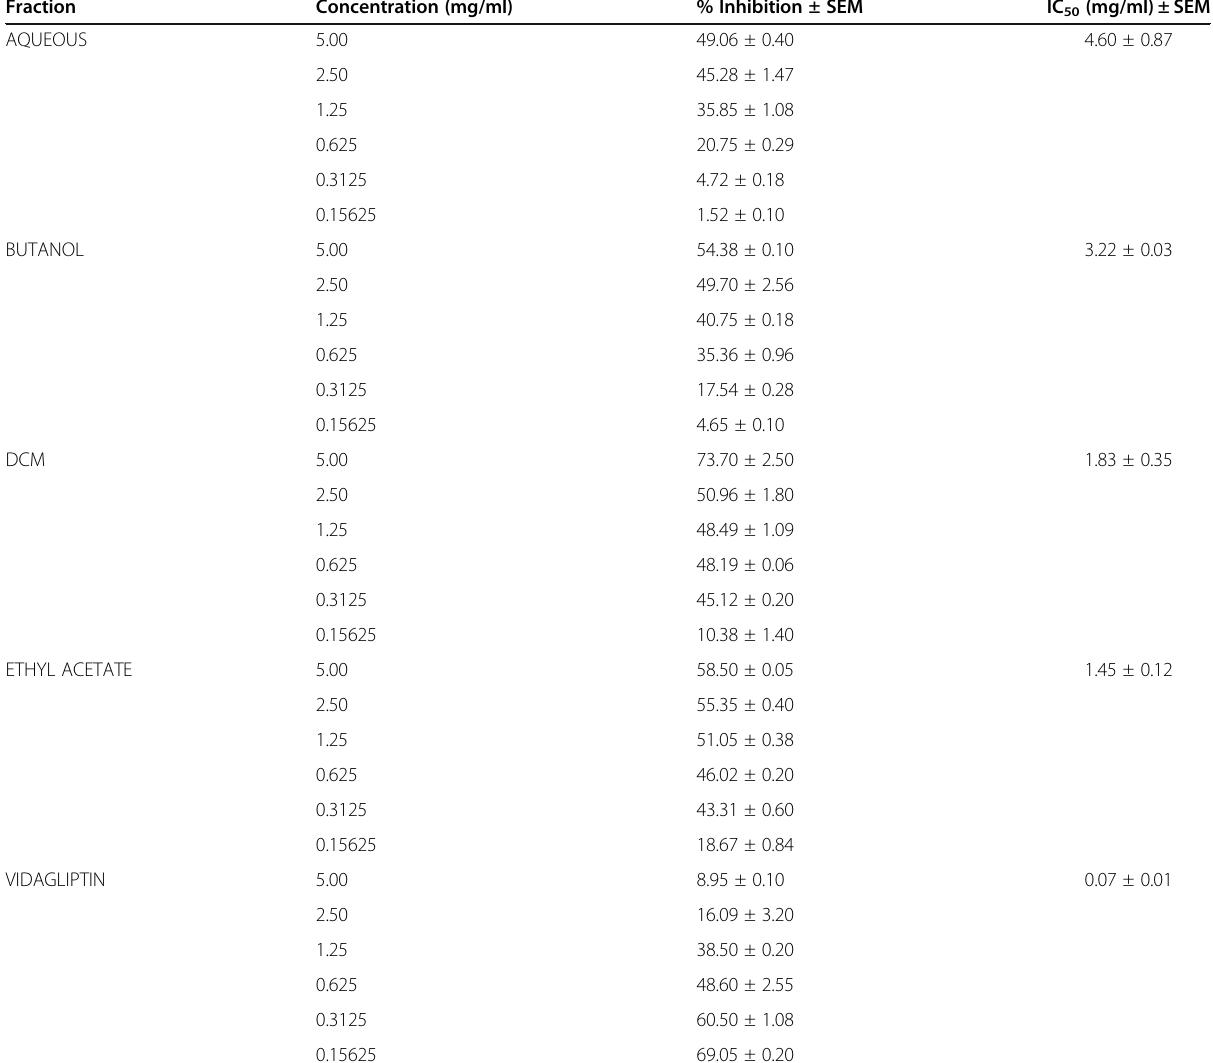
Table 4 In vitro inhibitory effects of different solvent fractions of P.guineense on the activity of dipeptidyl peptidase – IV (DPP-IV)